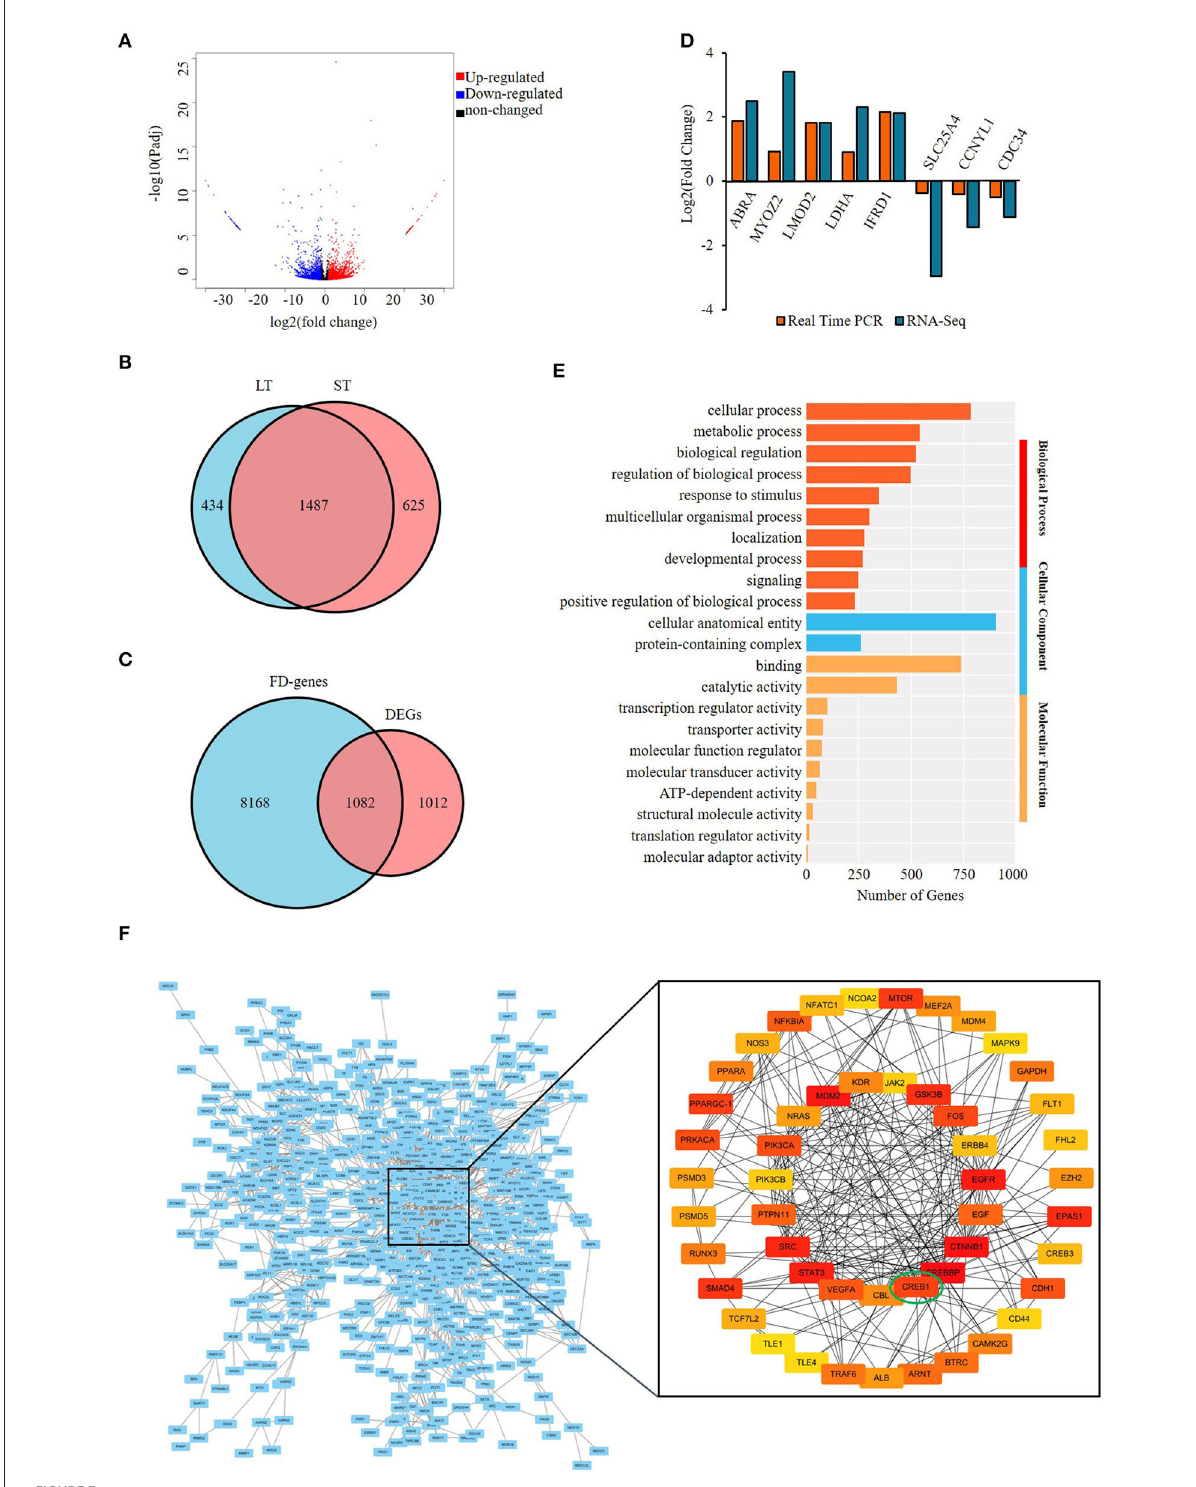
FIGURE3 Screening and enrichment analysis of the differentially expressed genes (DEGs) in semitendinosus compared with longissimus thoracis. (A) Volcano plot of DEGs; (B) Venn diagram of differentially expressed mRNAs; (C) Venn diagram of DEGs and fat deposition genes; (D) real-time PCR validation of DE mRNA; (E) Top 10 GO terms enriched by FD–DEGs in each category.; (F) Protein–protein analysis of FD–DEGs. The minimum interaction score was set as 0.7. The color of the circle represents the degree of